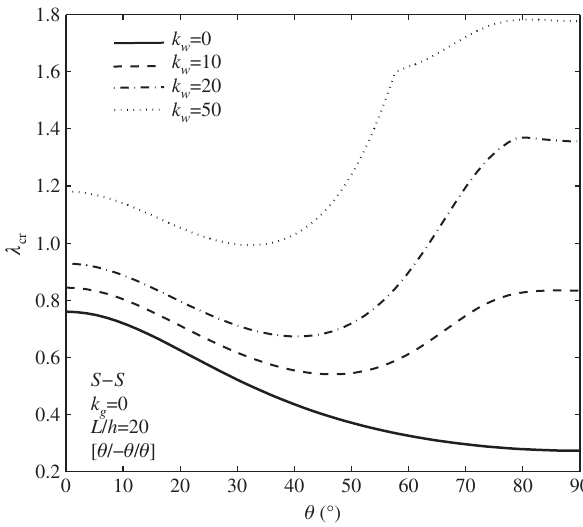
Figure 3 Influence of lay-up and the Winkler constant of elastic foundation on λ . cr cr